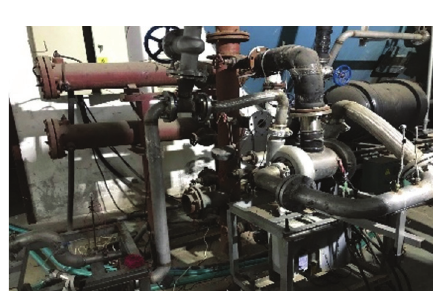
Figure 11: Electric compressor.